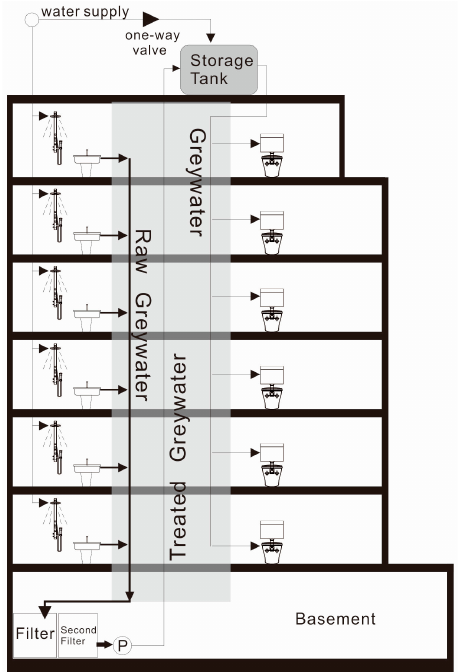
Figure 1. Conventional Greywater System.